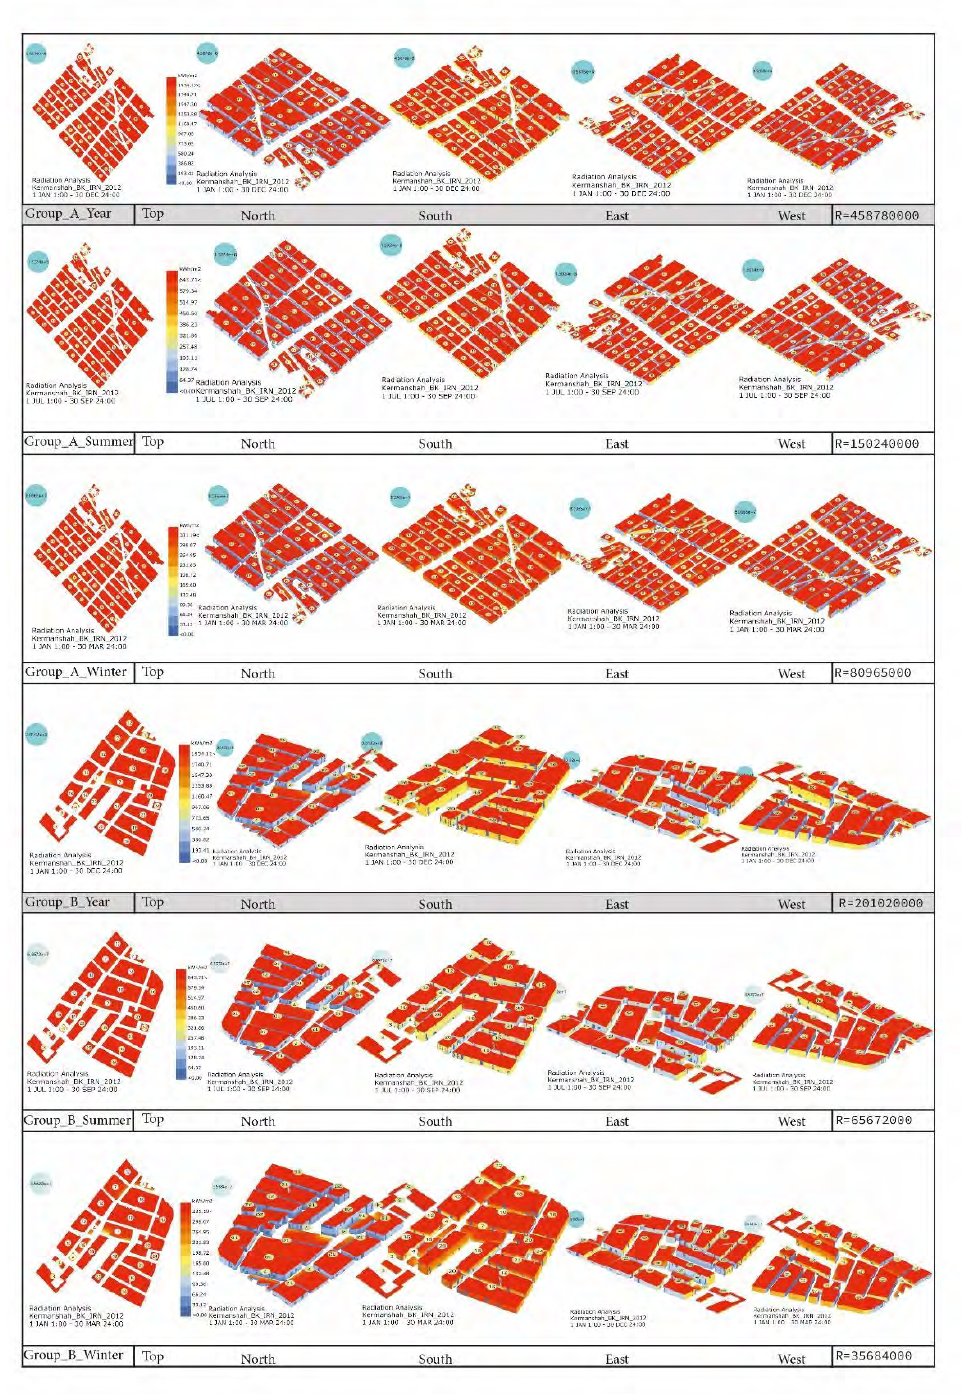
Figure 11 Calculation of solar radiation at sub-neighborhood scale for group A_B in winter and